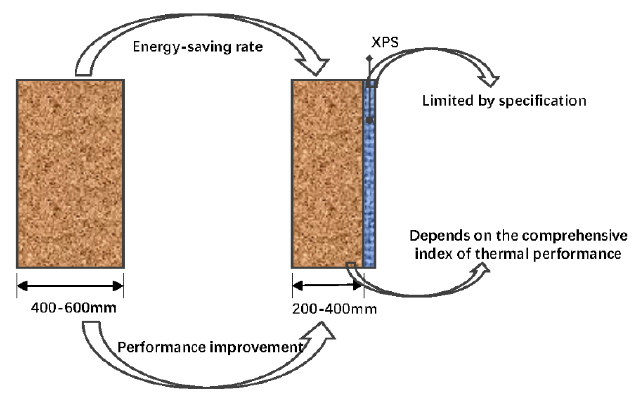
Figure 22. Applications ideas for RE materials.